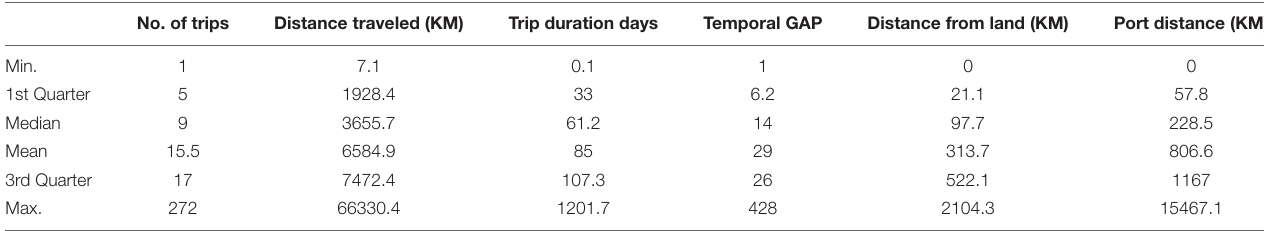
TABLE 1 | Summary of VMS data, including the number of trips in each quarter, the total distance traveled, the trip duration, number of gaps detected, distance from land traveled by the vessel, and the distance the vessel traveled to port. No. of trips Distance traveled (KM) Trip duration days Temporal GAP Distance from land (KM) Port distance (KM)